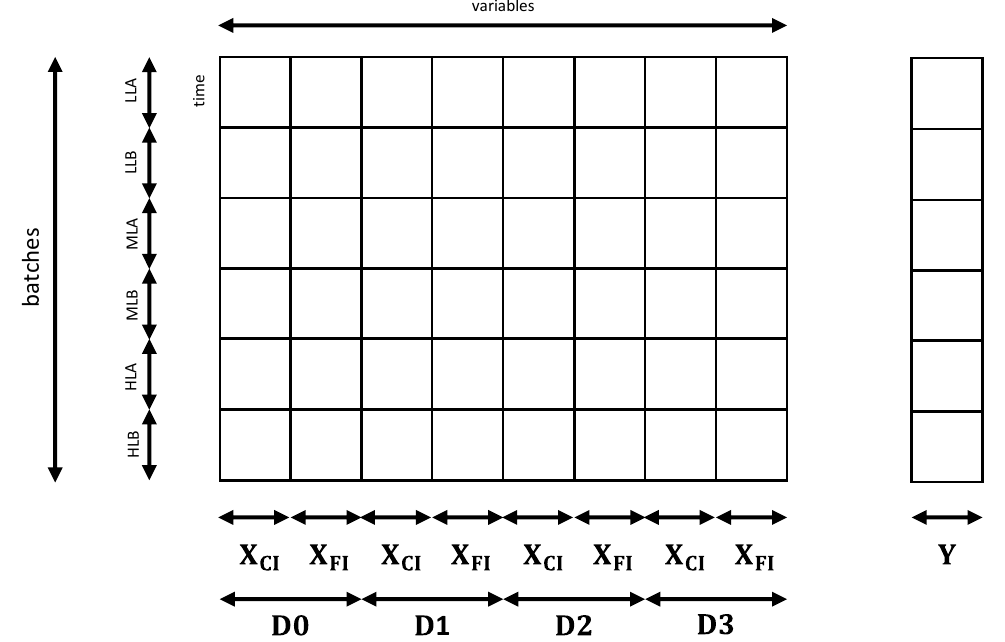
Figure 10. Sketch of the new predictor matrix to improve biomass concentration prediction. The number of variables was increased by using features extracted from wells at three additional dilutions of the original culture D0. The response Y consisted of the logarithm of the concentration. Table 3. Performance of the model that used dilutions to estimate biomass concentration.